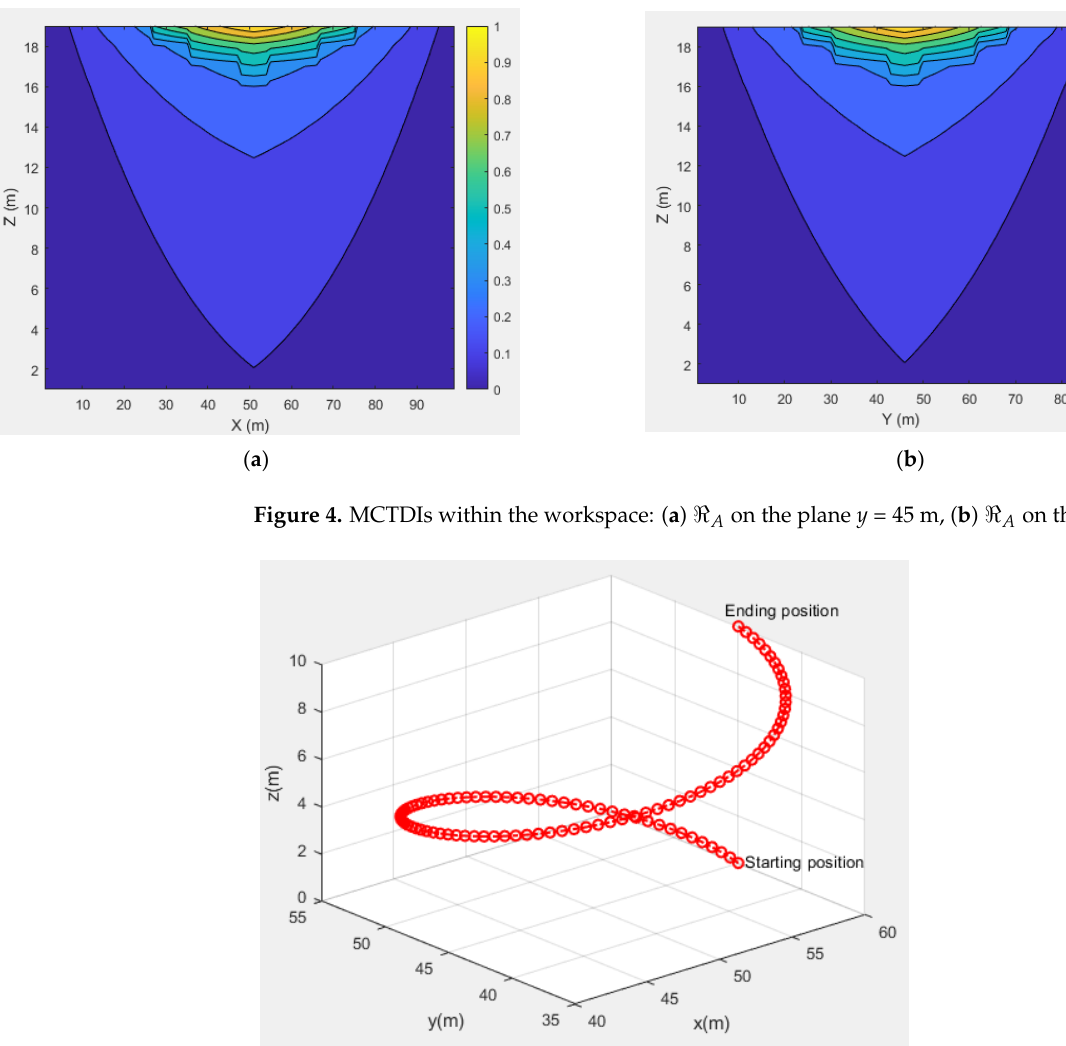
on the plane y = 45 m, ( b )  A